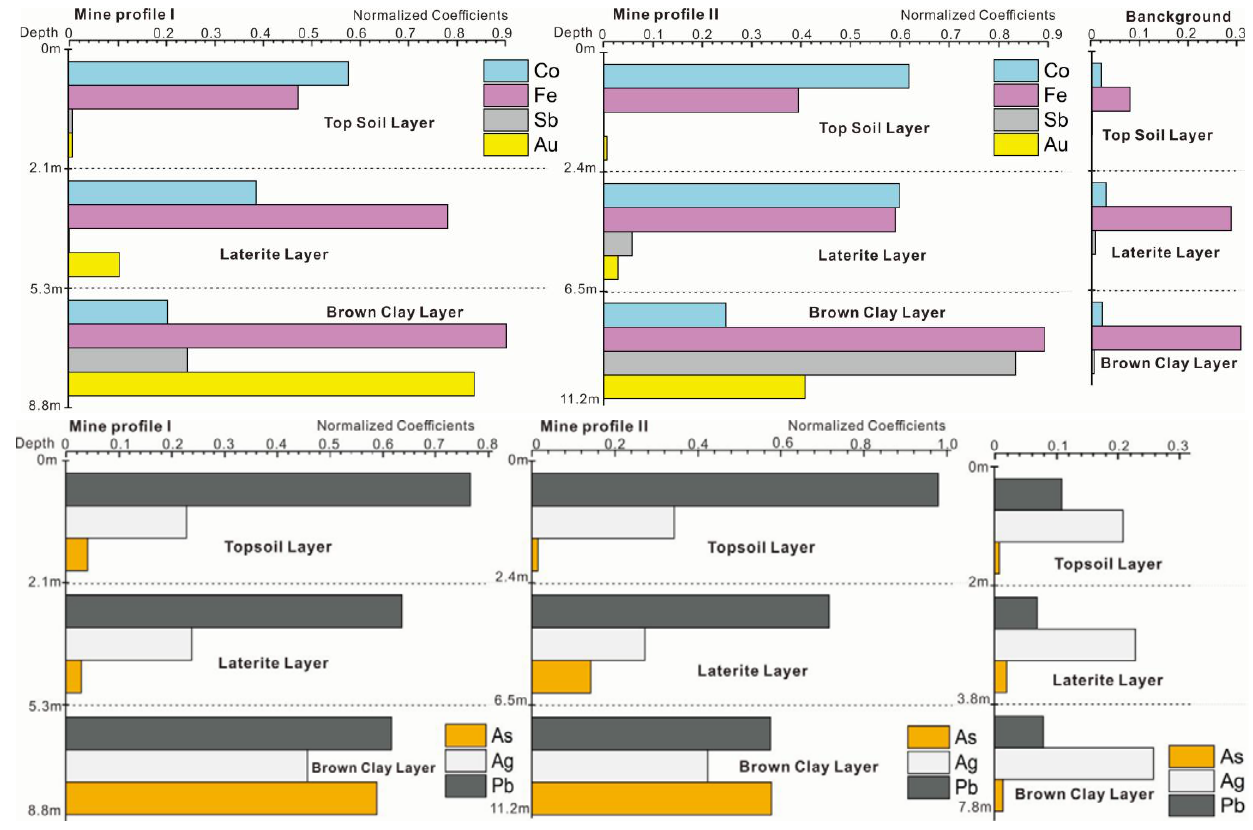
Figure 4. The content of each ore-forming elements in ore profile.